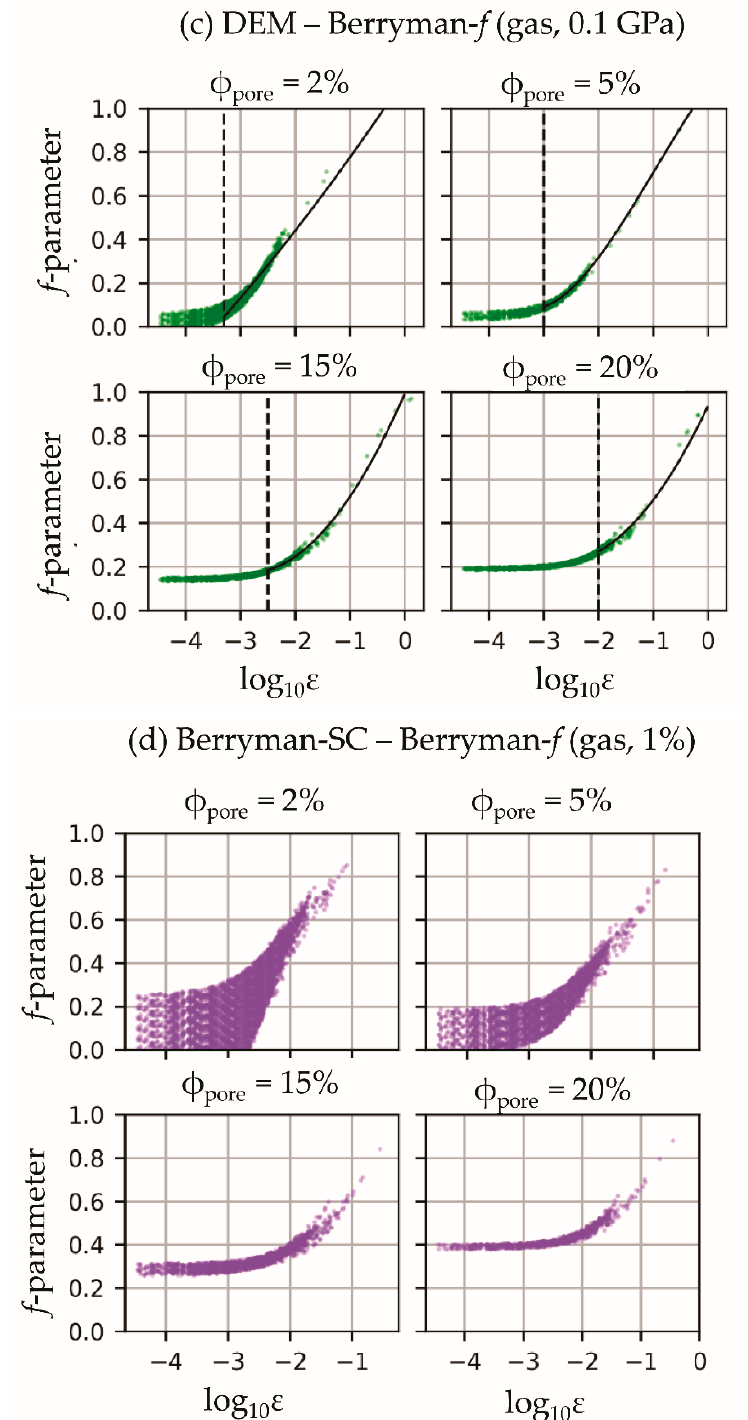
Figure 4. The f -parameter vs. crack density for fixed spherical porosity values. Effective properties are calculated with Berryman’s methods, voids are ( a ) brine and ( b ) gas saturated; ( c ) with DEM and Berryman- f methods, voids are gas saturated. The accepted difference between the effective moduli provided by Type 1 and Type 2 models in cases ( a – c ) is chosen as 0.1 GPa. ( d ) Effective properties are calculated with Berryman’s methods, voids are gas-saturated; the accepted difference between the effective moduli provided by Type 1 and Type 2 models is chosen as 1%. The meaning of numbers in parentheses is (type of saturation, accepted difference between the effective moduli provided by Type 1 and Type 2 models).